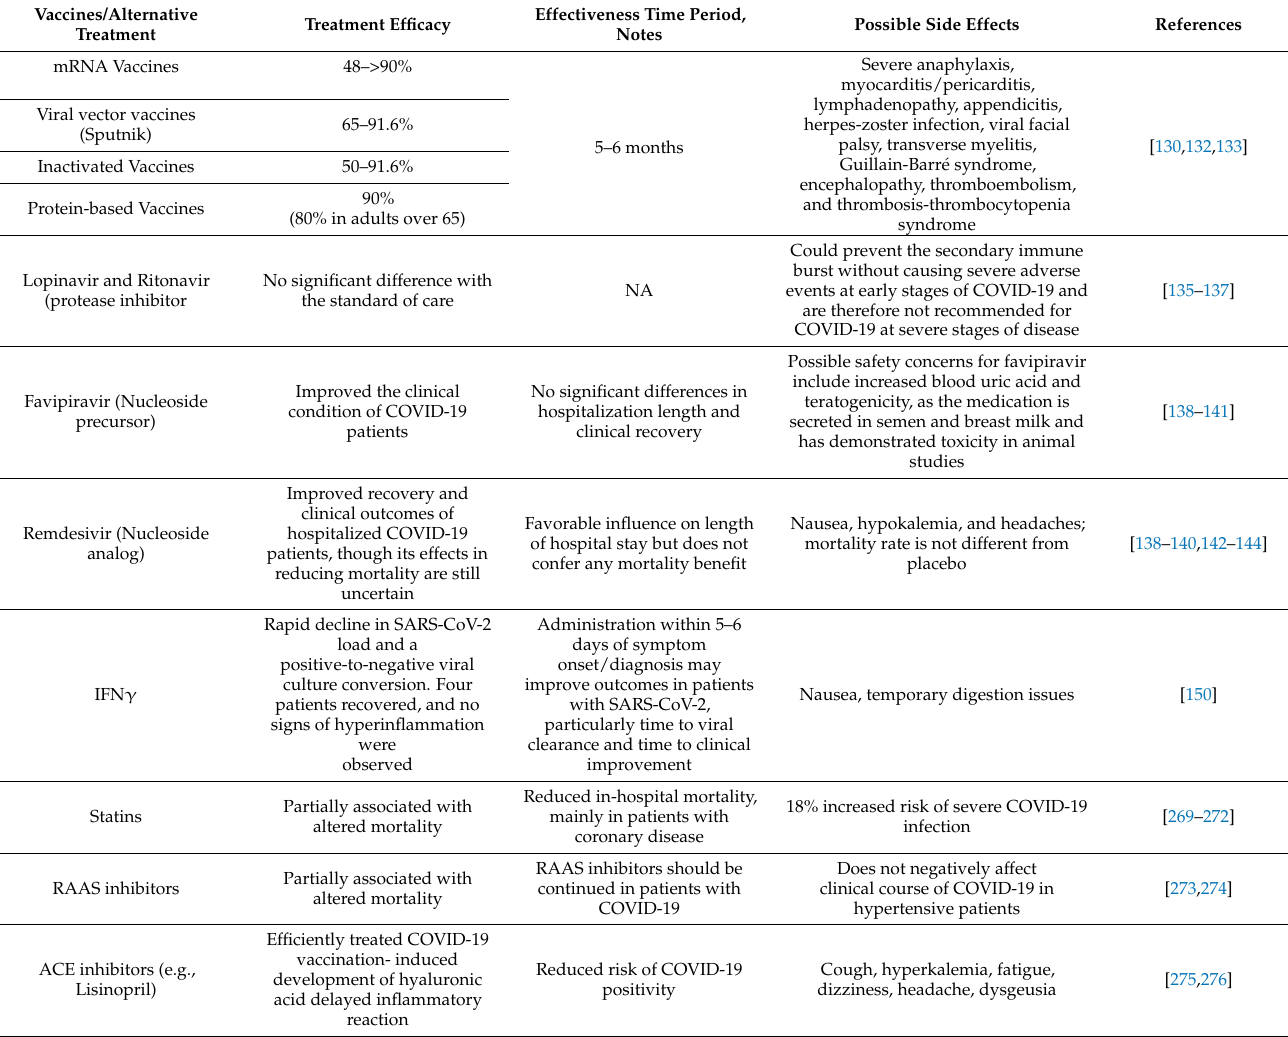
Table 5. COVID-19 Vaccines and Alternative